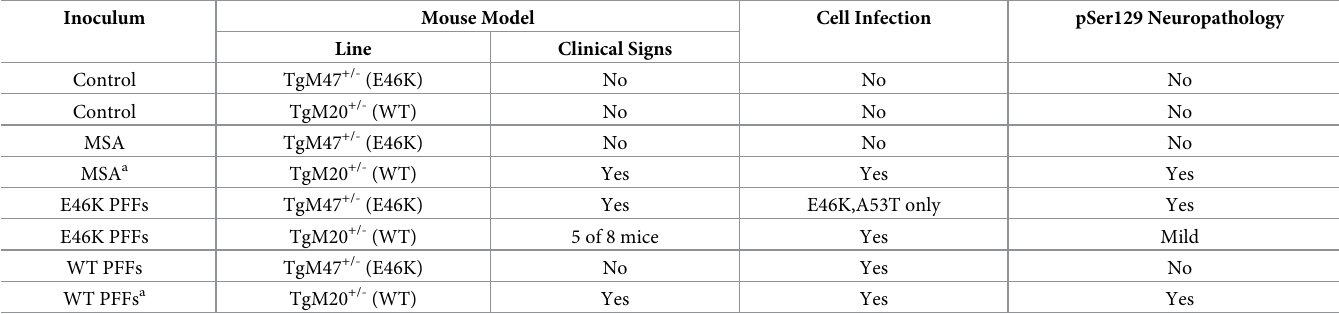
Table 5. Summary of transmission studies in mice expressing E46K or WT α -synuclein.